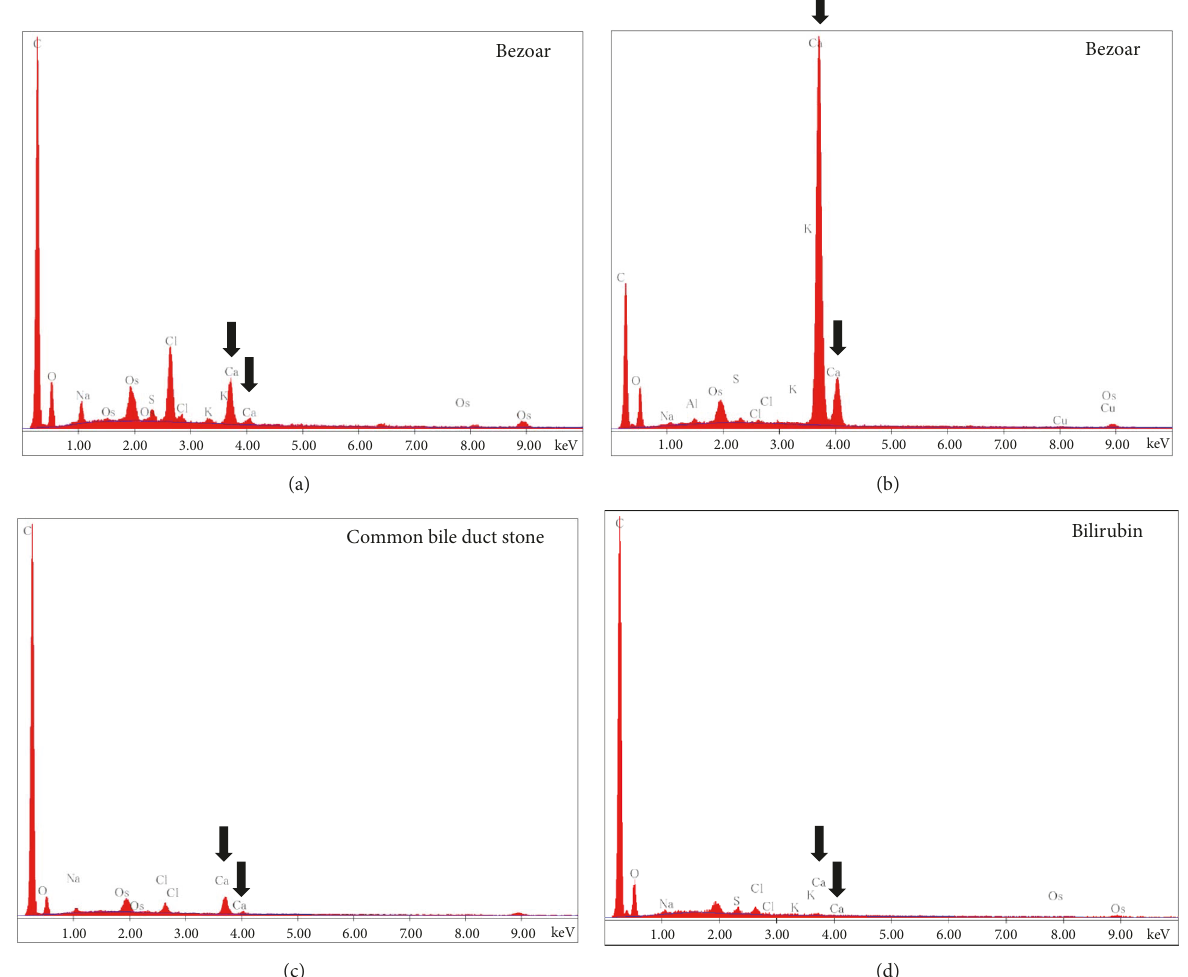
Figure 6: Results of EDX analysis of the bezoar’s external layer (a), the bezoar’s core (b), common bile duct stones (c), and commercially available bilirubin powder (d). Arrows indicate